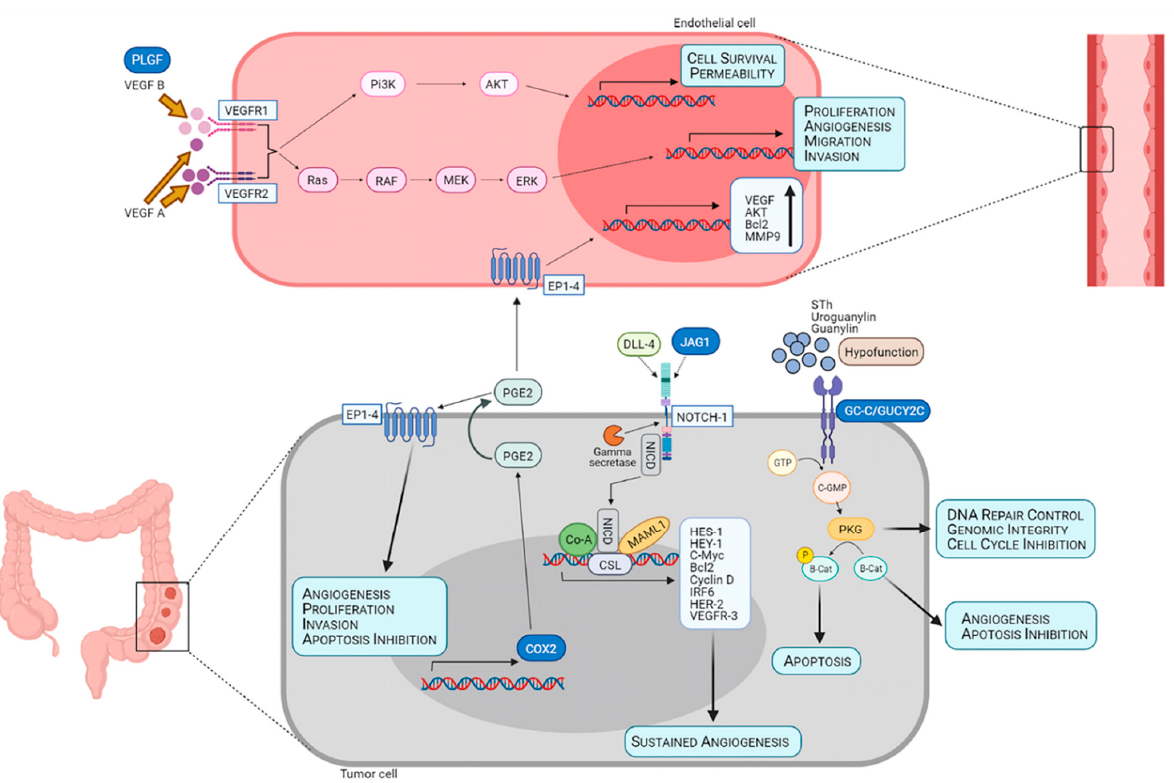
Figure 5. Schematic illustration summarizing the role of JAG1, PTGS2, GUCY2C and PLGF in tumor angiogenesis. PLGF (also termed PGF) may promote angiogenesis in vascular endothelial cells by binding to the VEGF receptor (VEGFR1), thereby increasing the availability of VEGF A for activation of VEGFR2, which exhibits higher kinase activity to induce angiogenesis-promoting signaling and other processes that favor tumor growth. The Notch pathway is activated through the binding of JAG1, among other ligands, to the receptor on the tumor cell surface, releasing the intracellular domain from the membrane that translocates to the nucleus, where it forms a complex to induce the transcription of several target genes that favor sustained angiogenesis. Transcription of PTGS2 (also termed COX2) mediates the production of prostaglandin E2 (PGE2) by tumor cells, which may act in a paracrine way by binding to prostaglandin receptors (EP1, EP2, EP3 or EP4) on the endothelial cell and inducing proliferation and angiogenesis, or in an autocrine way to further support angiogenesis and tumor promotion. In colon cancer, the tumor-suppressor gene GUCY2C (also referred to as GC-C) is upregulated but maintained in a hypoactivated state due to a lack of ligands, resulting in impaired signaling and leading to loss of genomic integrity, apoptosis inhibition and angiogenesis.